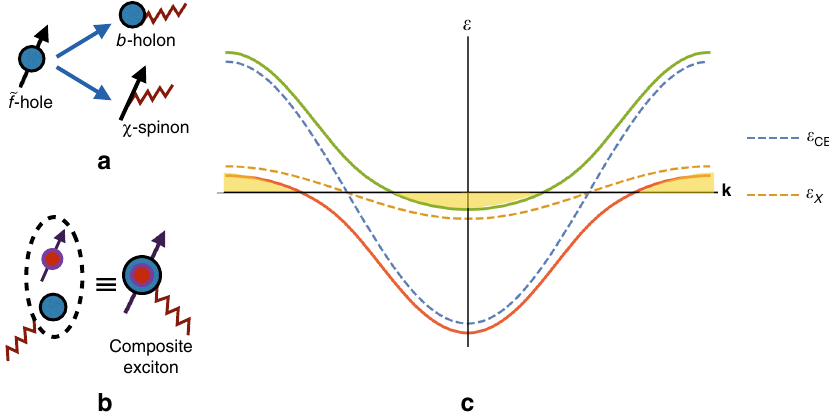
Fig. 1 Route to composite exciton Fermi liquids. a Slave-boson representation for the ~ f – hole in terms of a holon (blue circle) and spinon (black arrow), coupled mutually to a (zigzag line). b Strong binding of the conduction d – electron (red circle with arrow) to the holon leads to formation of a fermionic composite exciton coupled to the same a . c Two-band model when the f – valence fl uctuates between n f = 1 and 2. The composite exciton dispersion ε CE (blue dashed line) and a narrow spinon dispersion ε χ (orange dashed line) shown for the gauge-invariant combination ζ = t CE / t χ > 0. The hybridization between the two gives rise to two bands (orange and green solid lines) and as a result of the fi lling leads to a semi-metallic state (yellow shaded regions), where the volumes of the two pockets are equal. For ζ < 0, the resulting state would be an